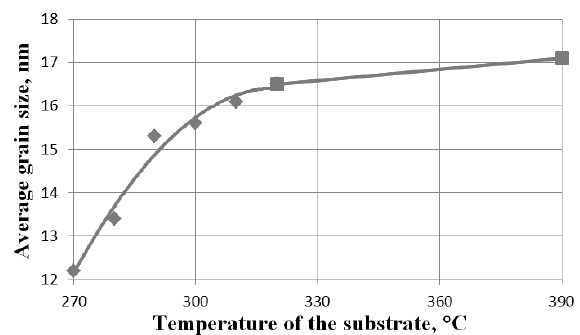
Fig. 1. The dependence of the average grain size on the substrate temperature in the FeNi film.